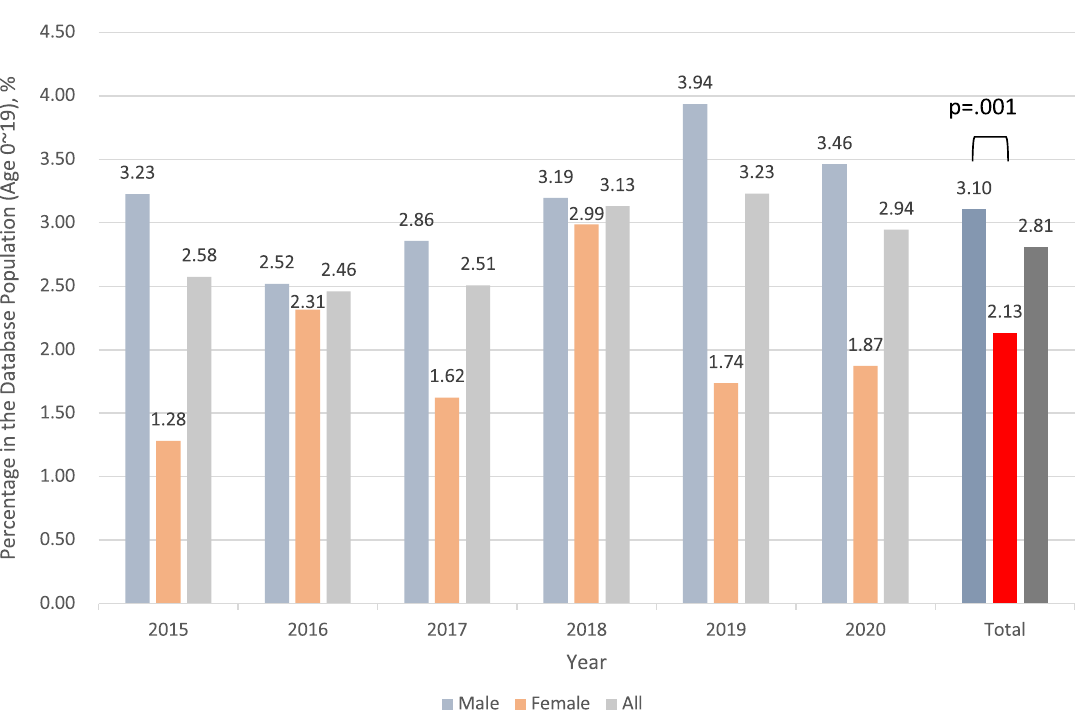
Figure 2. Sex-specific and total percentages of non-accidental injuries among trauma events presenting to emergency departments (age at injury from 0 to 19